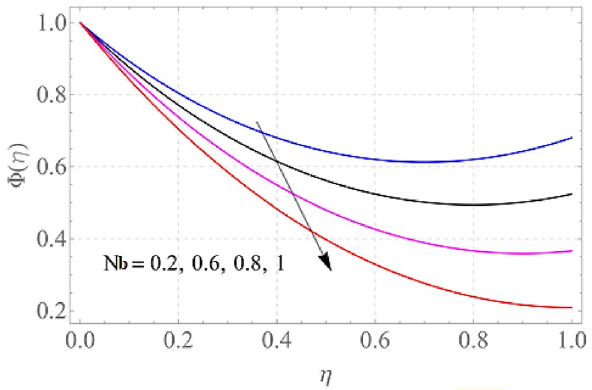
Figure 14. Alterations in �(η) as Nb raises. When M = S = 0.1, Pr = 6.2, Gc = 0.2, Ec = 1, Nt = 0.3, Sc = 0.3 .